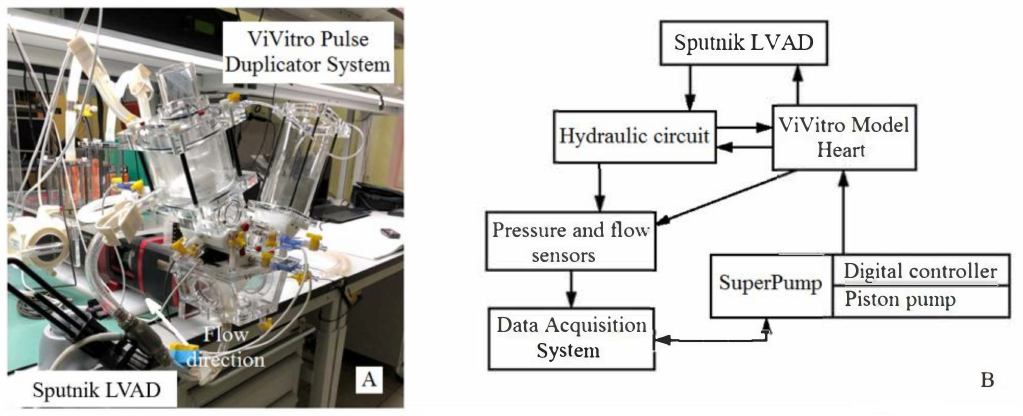
Figure 1. Image ( A ) of ViVitro Pulse Duplicator System SD2001-1 with the Sputnik LVAD connected ( B ) and the block